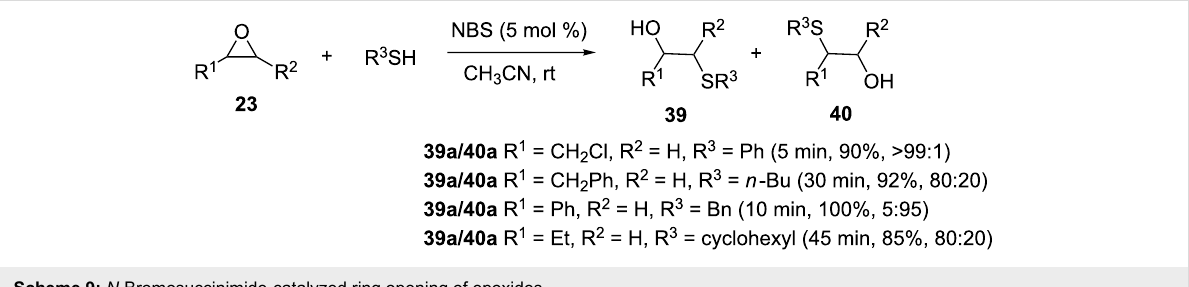
Scheme 9: N -Bromosuccinimide-catalyzed ring opening of